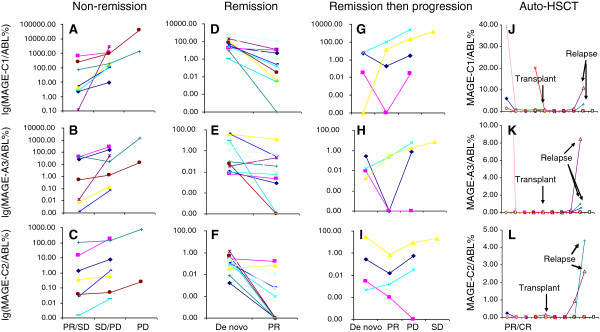
CT antigen expression levels correlate with the clinical course of multiple myeloma. The expression levels of MAGE-C1/CT7 (A), MAGE-A3 (B) and MAGE-C2/CT10 (C) increased in eight patients who did not respond to treatment and showed non-remission courses with time. (D, E, F) The expression levels of the three CT antigen genes were reduced in 11 patients who responded to treatment. (G, H, I) Four patients with de novo disease experienced partial remission and then disease progression; the expression levels of the three CT antigen genes fell and then rose in two patients, while the other two patients showed increased expression levels before the disease progressed at later time points. (J, K, L) The expression levels of the three CT antigen genes were reduced or negative in 13 patients after auto-HSCT. In three patients who relapsed after auto-HSCT, one had an increased expression level of MAGE-A3, and the other two had increased expression levels of all three genes.